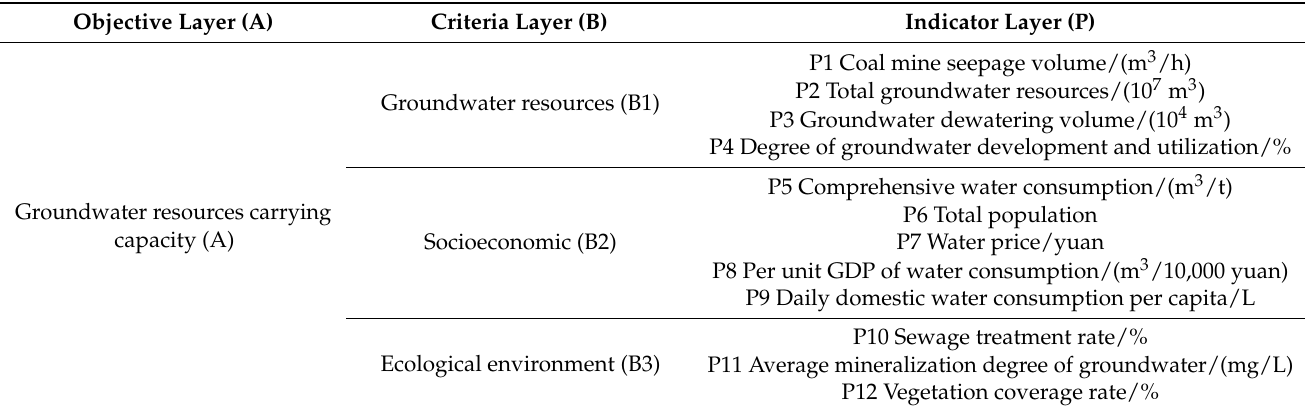
Table 1. Evaluation index system of groundwater resources carrying